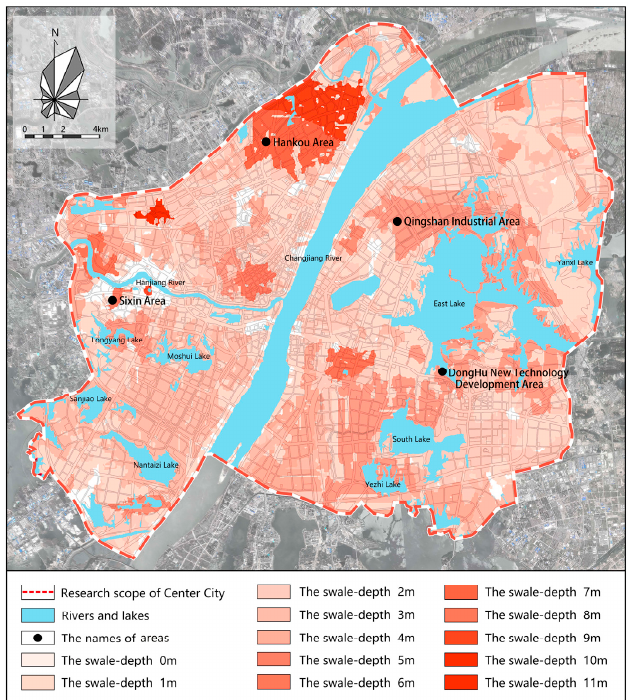
Figure 7. Location of downtown Wuhan and flood-submerged area.